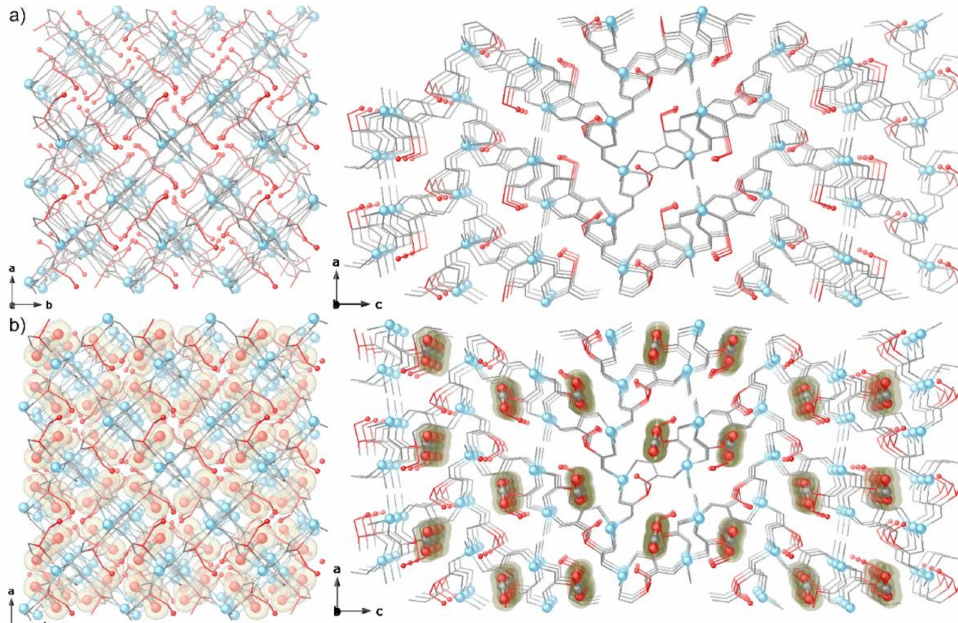
Figure 3. Perspective views of the porous networks of 1 ( a ) and CO 2 @1 ( b ) along the c ( left ) and b ( right ) axes. Color code: Zn atoms and C and O from guest CO 2 molecules are represented as cyan, grey, and red spheres, whereas serimox ligands—with the exception of serine residues—are represented by grey sticks. –CH 2 OH groups and N atoms are represented as cyan, red, and deep blue spheres, respectively, whereas C atoms are depicted as grey